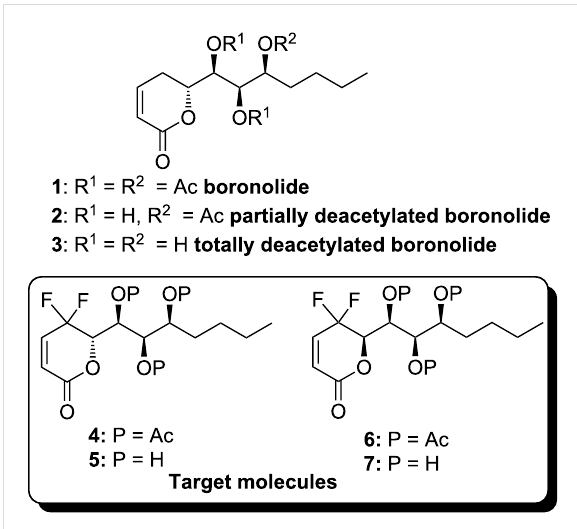
Figure 1: Boronolide ( 1 ), boronolide analogues 2 – 3 and gem -difluoro- methylenated analogues 4 – 7